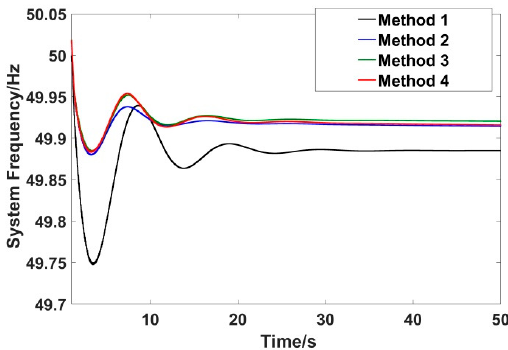
Figure 6. System frequency curves.